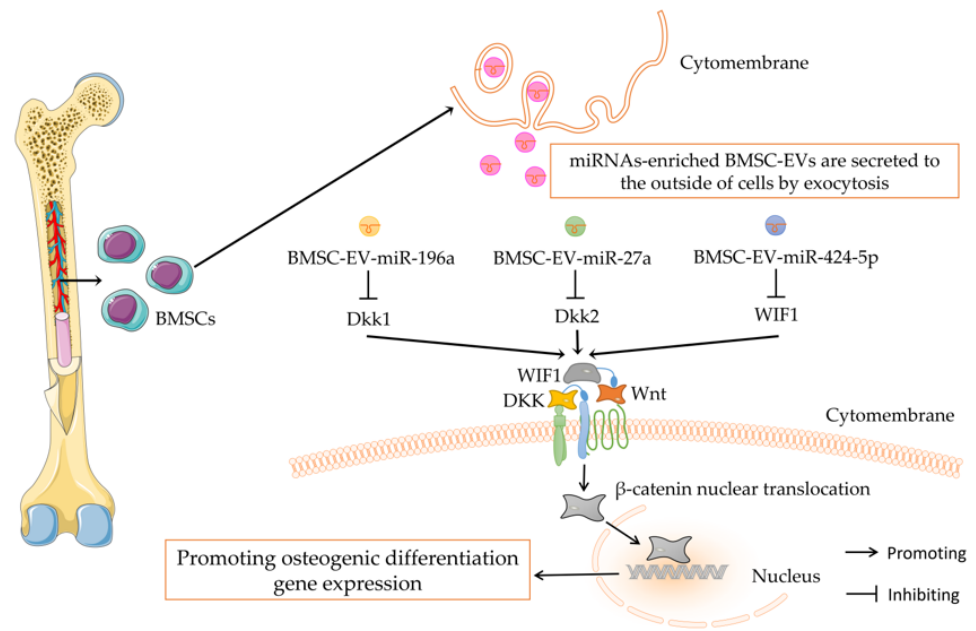
Figure 1. Wnt/ β -catenin signaling mediates the regulation of BMSC-EV-miRNAs on bone Figure 1. Wnt/β -catenin signaling mediates the regulation of BMSC-EV-miRNAs on bone metabo- lism.